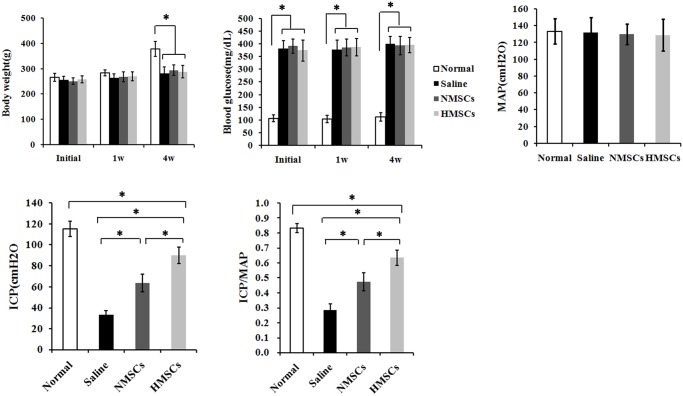
Body weight, blood glucose and erectile function.STZ injection caused a significant body weight loss at the 4st week and continual increase of blood glucose concentration in the diabetic groups compared to age-matched controls. There were no difference among diabetes groups in both body weights and blood glucose level. Erectile function: The ICP value of treatment with N-AMSCs or H-AMSCs is increased and the ratio of total ICP to MAP was also calculated. *P<0.05;